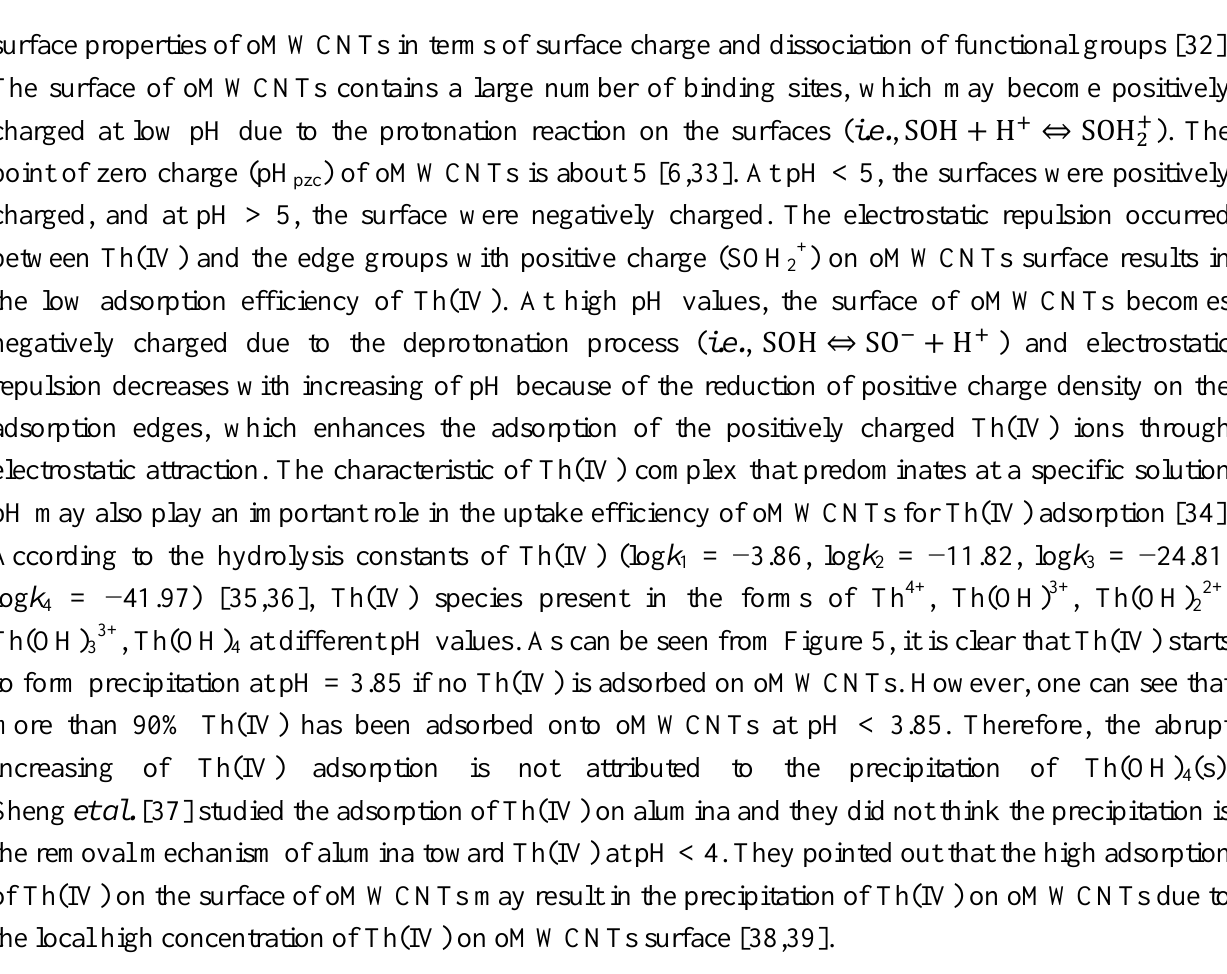
Figure 5. Adsorption of Th(IV) on oMWCNTs as a function of pH, m/V = 0.1